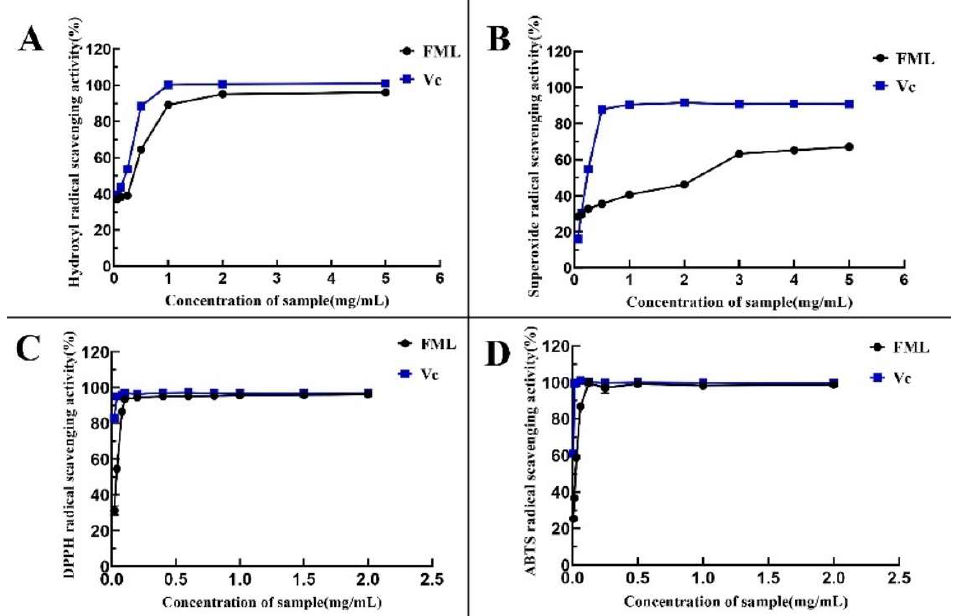
Figure 7. Determination of the antioxidant activity of the five compounds: ( A ) DPPH · scavenging ability; ( B ) · OH scavenging ability; ( C ) O 2 − scavenging ability; ( D ) ABTS scavenging ability. Vc, vitamin C.